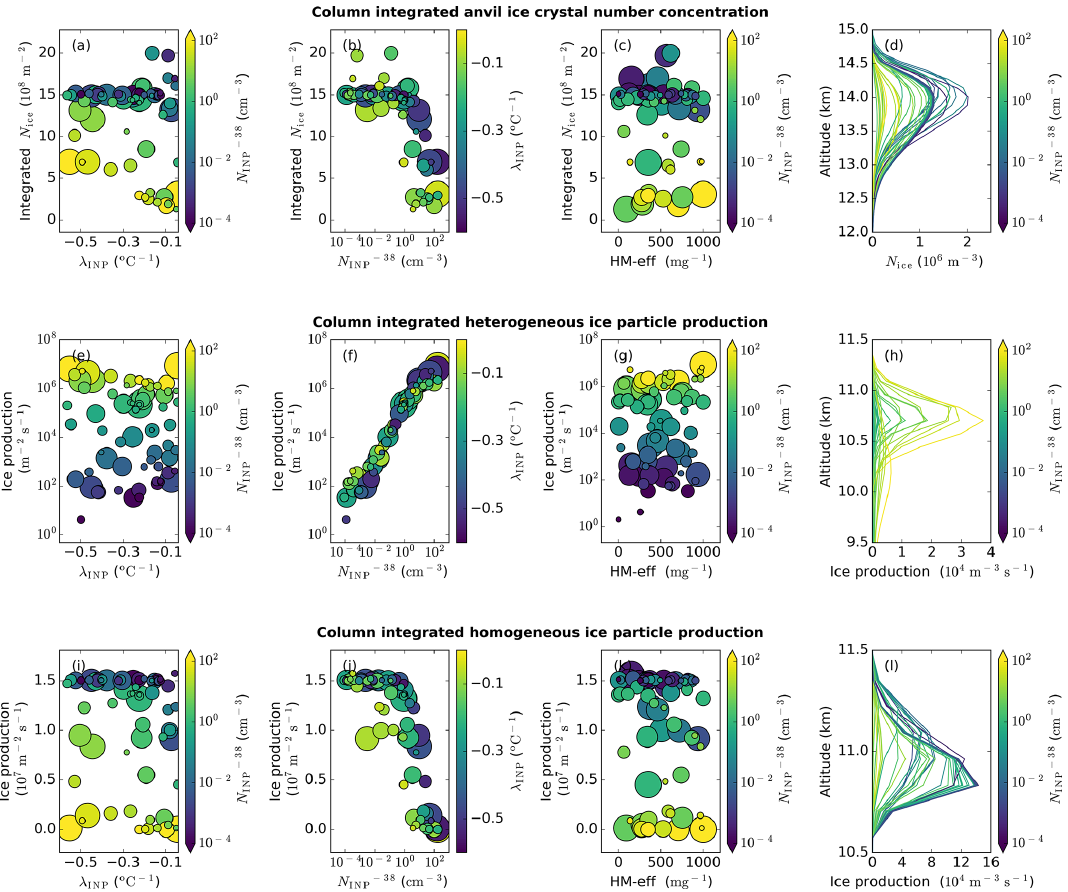
Figure 6. Anvil ICNC and ice particle production rates. Dependence of anvil ice crystal number concentration (a–d) , ice particle production by heterogeneous freezing (e–h) , and ice particle production by homogeneous freezing (i–l) on the three uncertain input parameters: λ INP ( a , e , and i ), N INP − 38 ( b , f , and j ), and HM-eff ( c , g , and k ). In-cloud profiles of anvil ICNC (d) , ice particle production by heterogeneous freezing (h) , and ice particle production by homogeneous freezing (l) in all simulations coloured by N INP − 38 . For panels (a) , (e) , and (i) the colour of the markers indicates N INP − 38 and the marker size indicates HM-eff. For panels (b) , (f) , and (j) the colour of the markers indicates λ INP and the marker size indicates the HM-eff. For panels (c) , (g) , and (k) the colour of the markers indicates N INP − 38 and the marker size indicates the λ INP value. Panels (a) – (d) are the average of the cloud property between 150 and 240min (anvil stage) in the simulation, while panels (e) – (l) are the average of the relevant cloud property between 60 and 180min (convective stage) in the